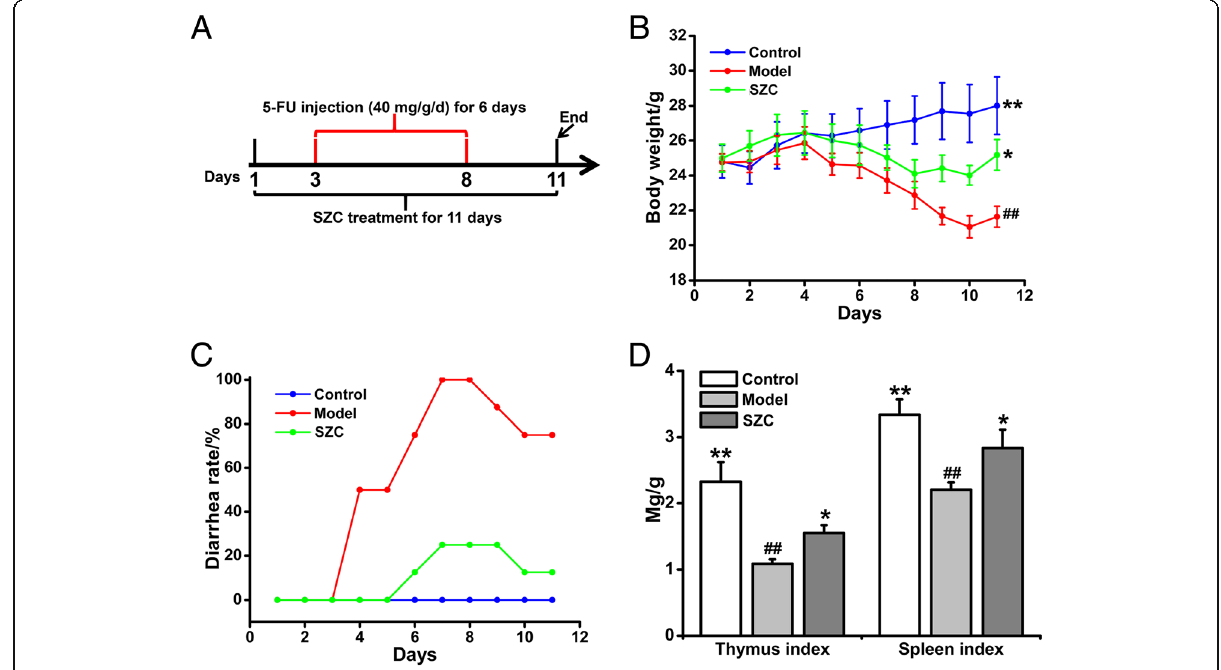
Fig. 2 The effects of SZC on body weight, diarrhea, and thymus/spleen indexes in mice with CID ( n = 8, male/femal = 4). ( a ) Experimental process of CID. ( b ) The daily-changed body weight of each group. ( c ) The daily-changed diarrhea rate of each group. ( d ) Thymus and spleen indexes of each group. Data were presented as means ± SEM. * P < 0.05 and ** P < 0.01 compared with model, # P < 0.05 and ## P < 0.01 compared with